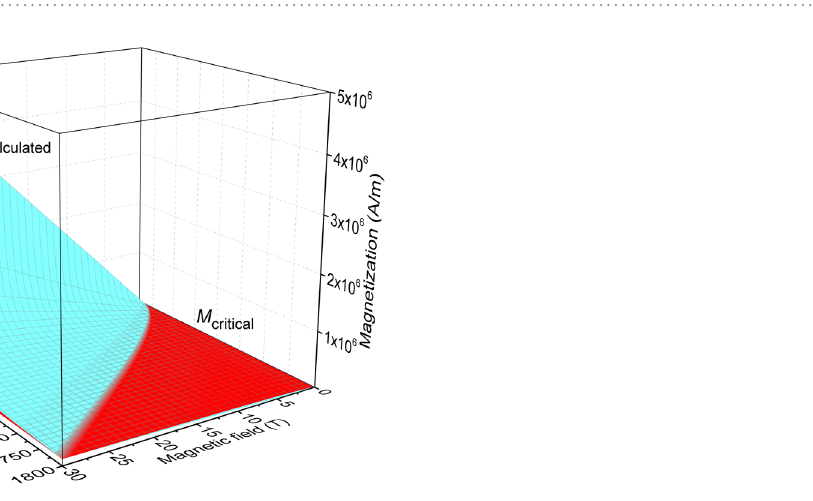
Figure 6. Experimental magnetizations and critical magnetization for the existence of normal-field instability in liquid Co